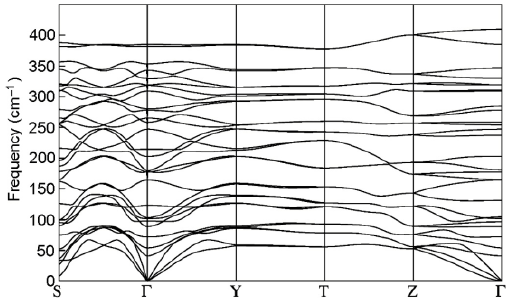
Figure 10. The phonon band dispersion of the GaInS 3 compound.